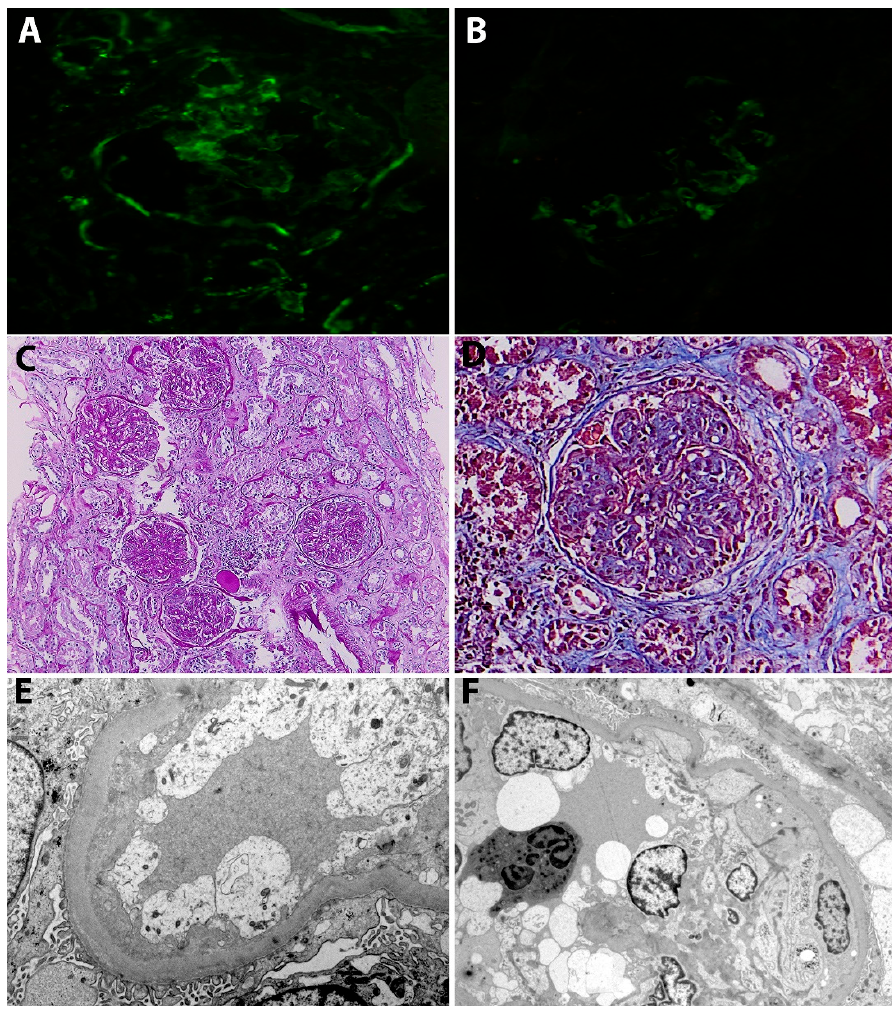
Figure 2. ( A ) Immunofluorescence. Moderate staining for IgG in the mesangium and along the glomerular capillary walls. ( B ) Immunofluorescence. Moderate staining for C3 in the mesangium and along the glomerular capillary walls. ( C ) Light microscopy (PAS staining). Glomeruli showing a membranoproliferative pattern with diffuse lobular accentuation (mesangial expansion with hypercellularity, endocapillary and extra-capillary hypercellularity). There is also moderate tubular atrophy and interstitial fibrosis and arteriosclerosis. ( D ) Light microscopy (Masson staining). Glomerulus with a membranoproliferative pattern of injury and a fibro-cellular crescent. Additionally, there is mesangial expansion due to accumulation of extracellular matrix, consistent with lesions of class II diabetic nephropathy ( E ) Electron microscopy. Podocytes showing diffuse foot process effacement. Additionally, there are swollen glomerular endothelial cells with loss of fenestrations and glomerular basement membrane thickening (460 nm). ( F ) Electron microscopy. Podocytes showing diffuse foot process effacement. There is also severe endothelial injury and endocapillary hypercellularity.